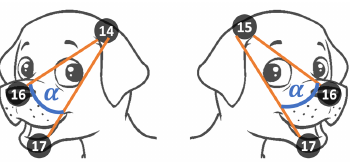
Figure 7. Calculation of the mouth condition.